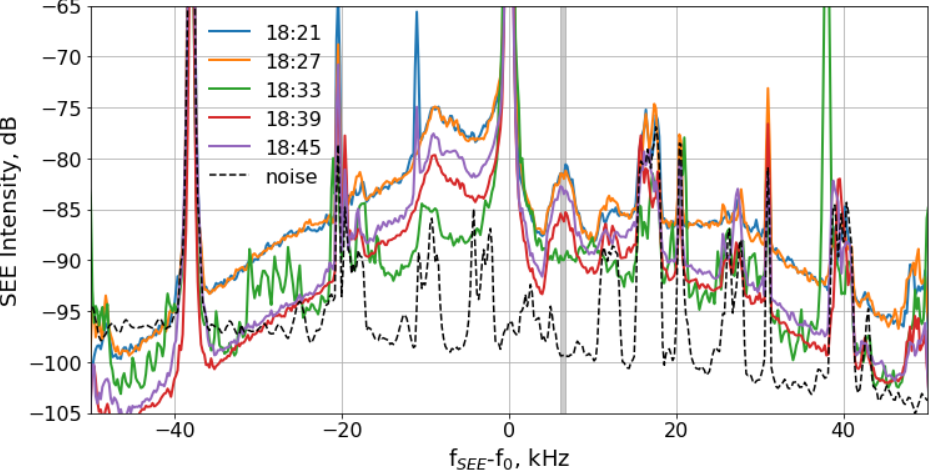
Figure 5. SEE spectra obtained at two minutes after continuous pumping switch on during the cycles shown in the Figure 4. Black dashed line corresponds to the spectrum of the background noise and